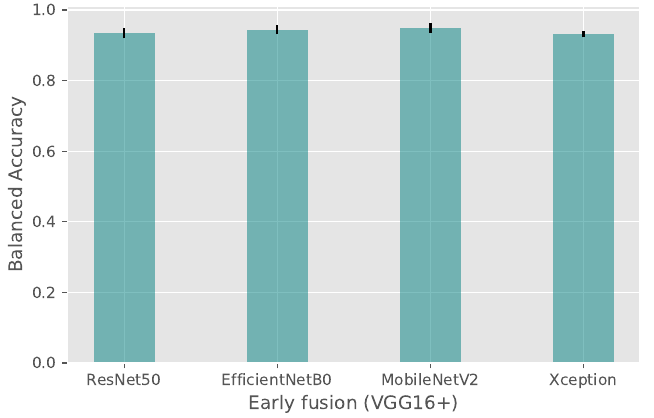
Figure 5. Comparison of four early fusion-based models. Here, VGG16 + MobileNetV2 achieves the best performance (94.89% ±